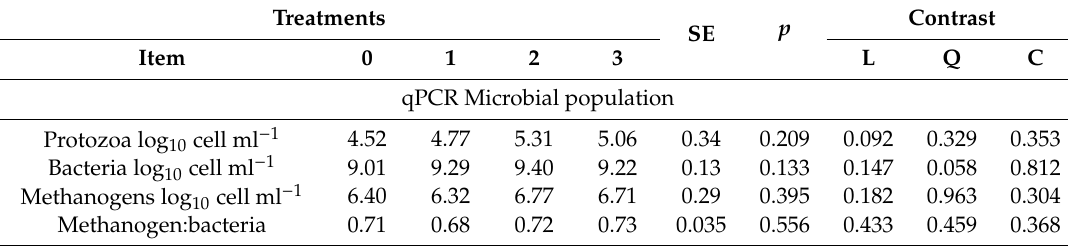
Table 7. Estimation of ruminal microbial population by quantitative polymerase chain reaction.